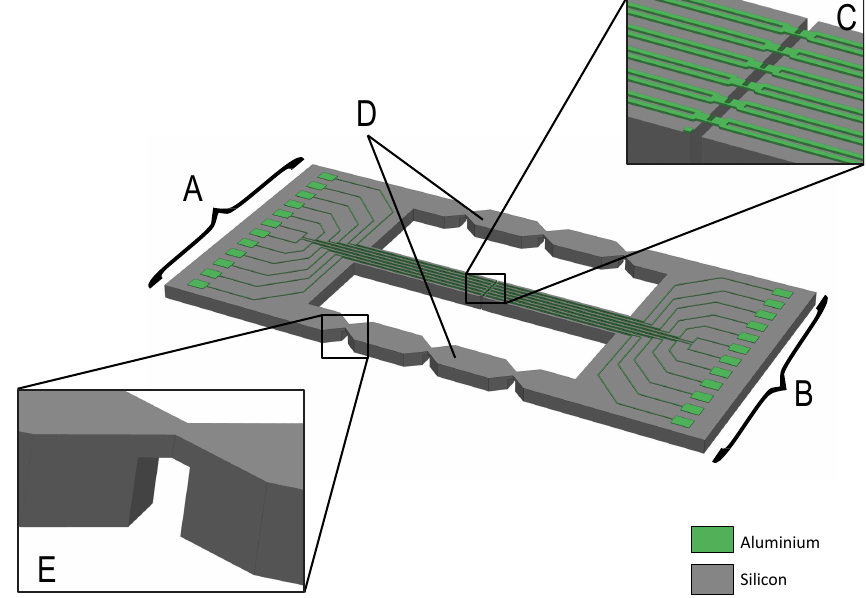
Figure 2. Schematic representation of the test chip. Here, A and B represent the main islands in between which the interconnects are suspended, shown in C. These interconnects are kept in place by the two temporary support beams, represented by D, each containing three v-notches. In order to break these notches easily the thickness of the Si is reduced, as shown in